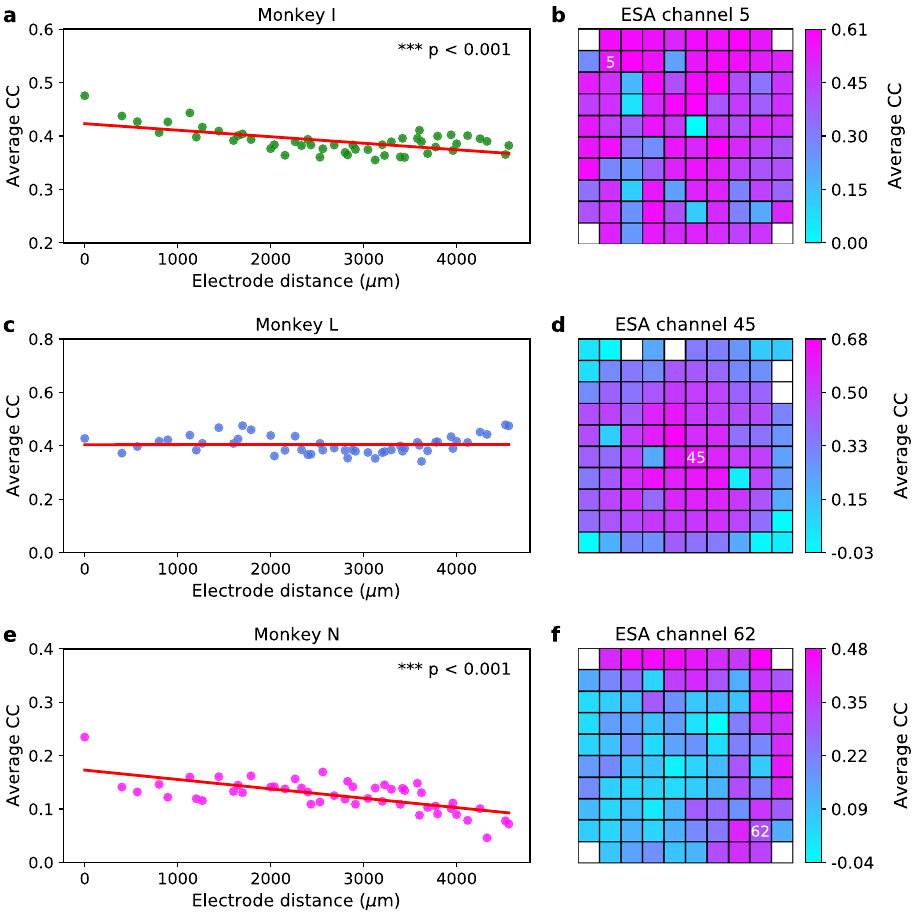
Figure 5. LFP channel importance score (quantified in terms of average CC) for ESA inference across subjects. ( a , c , e ) Scatter plot of LFP importance score over inter-electrode distance (μm) from monkey I, L, and N, respectively. Red solid lines represent linear regression lines used to test whether or not there is a significant linear trend between inter-electrode distance and LFP channel importance score. Asterisks indicate that there is a significant linear trend (two-tailed one-sample t test; ** p < 0.01 , *** p < 0.001 ). ( b , d , f ) Examples of heatmap of LFP channel importance score for ESA inference from monkey I (channel 5), monkey L (channel 45), and monkey N (channel 62), respectively. The importance score is mapped onto a 10 × 10 grid spatially corresponding to Utah electrode array configuration. white numbers inside the grids denote the ESA channel being inferred. White boxes on the grid represent unused (unconnected) electrodes. The larger the average CC, the more important is the channel for the